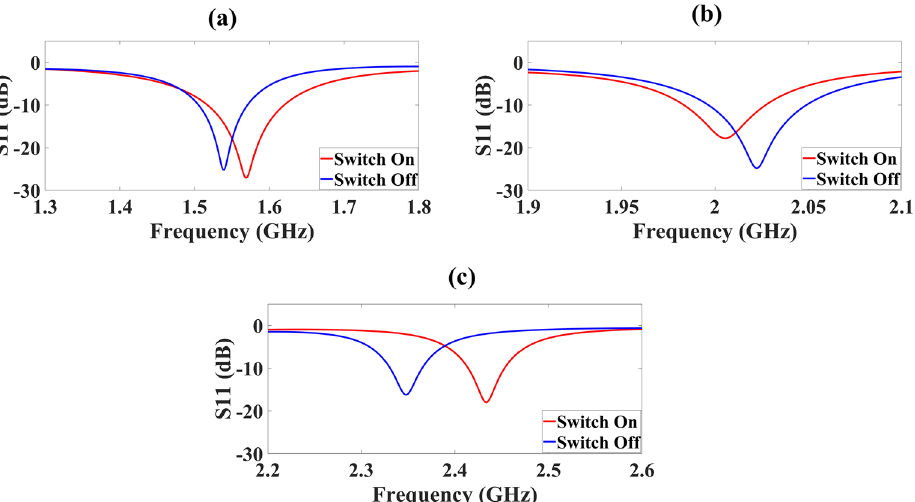
Figure 2. Simulated results of reflectance response (S 11 ) for switching scenarios of three pin diodes for 1.9 GHz to 5.4 GHz (a) for 1.3 GHz to 1.8 GHz, the frequency reconfigures from 1.539 GHz to 1.569 GHz (b) for 1.9 GHz to 2.1 GHz, the frequency reconfigures from 2.006 GHz to 2.022 GHz (c) for 2.2 GHz to 2.6 GHz, the frequency reconfigures from 2.348 GHz to 2.434